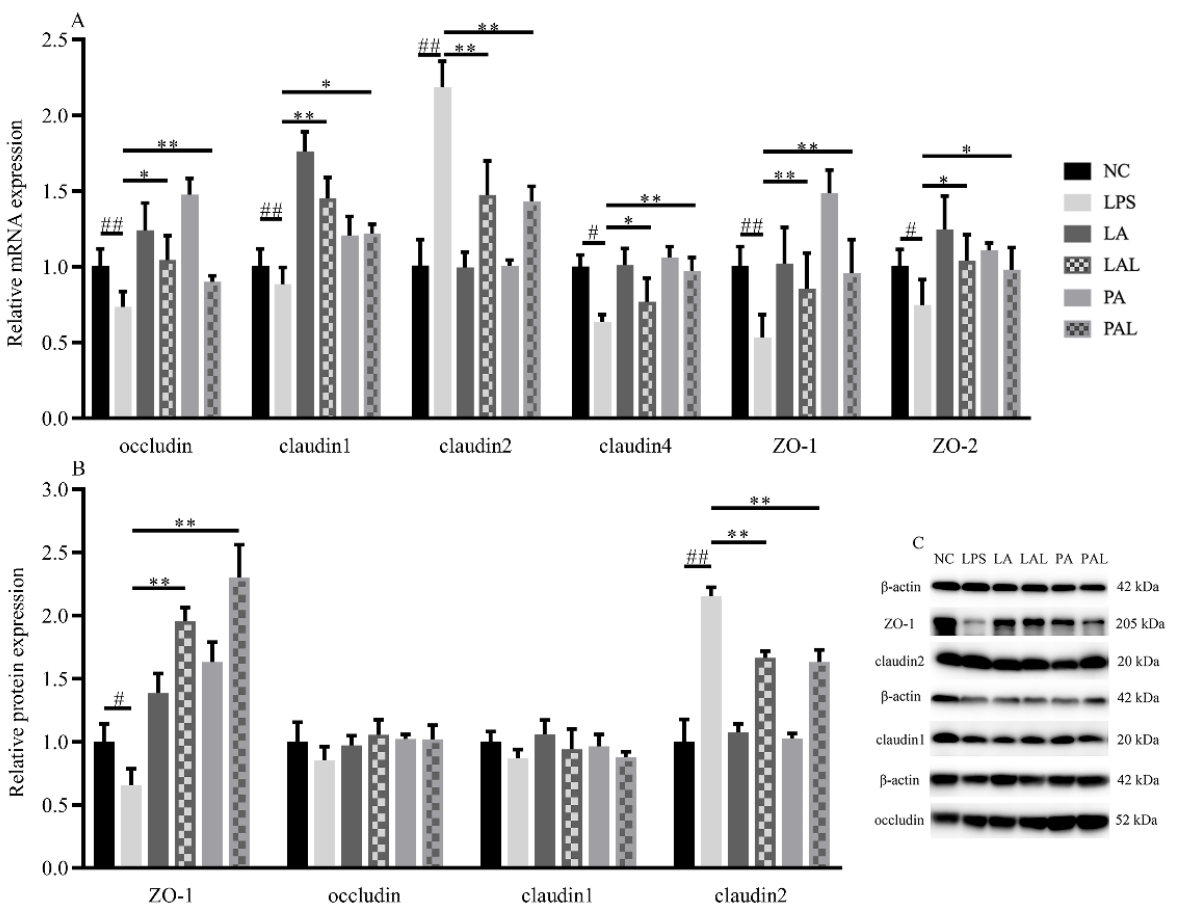
Figure 3. A. muciniphila affects the expression of tight junction proteins. ( A ) The level of relative mRNA expression, ( B , C ) and protein expression of tight junction proteins. ** p < 0.01, * p < 0.05, compared with LPS group. ## p < 0.01, # p < 0.05, compared with NC group. Data are expressed as mean ± S.D. ( n = 6). NC, control group. LPS, lipopolysaccharide-damaged group. LA, live A. mucini- phila . PA, pasteurized A. muciniphila . LAL, live A. muciniphila + LPS. PAL, pasteurized A. muciniphila + LPS.